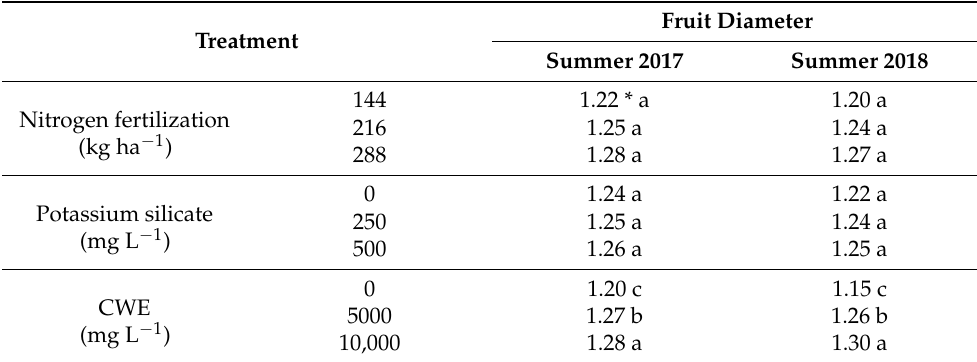
Table 4. Means of fruit diameter (mm), and fruit N content (g kg − 1 ) as affected by the nitrogen fertilization, potassium silicate, and clove extract’s main effects during 2017 and